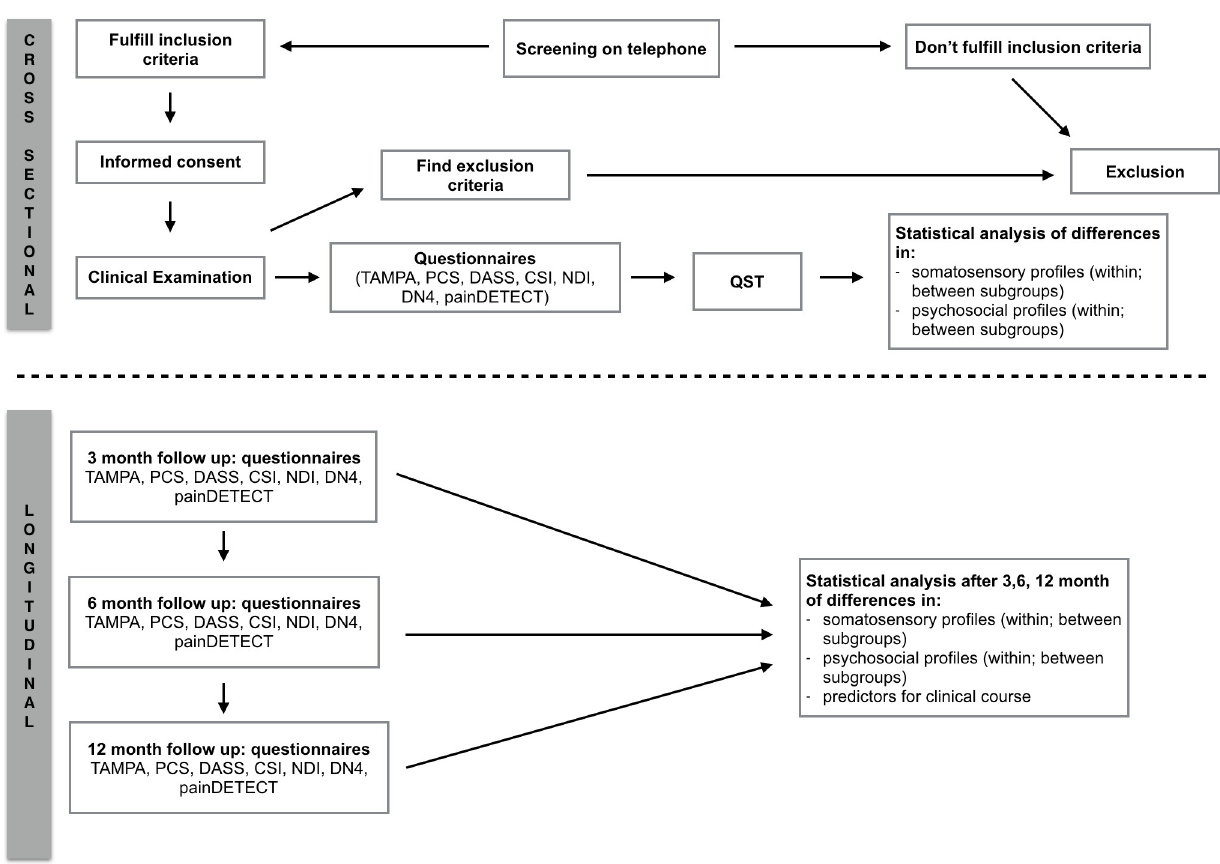
Fig 1. Flow chart testing procedure. NDI: Neck Disability Index, TSK: Tampa Scale of Kinesiophobia, PCS: Pain Catastrophizing Scale, CSI: Central Sensitization Inventory, DASS: Depression, anxiety and stress scale, DN4: Douleur Neuropathique 4 Questions, PD-Q: Pain DETECT Questionnaire, QST: Quantitative sensory